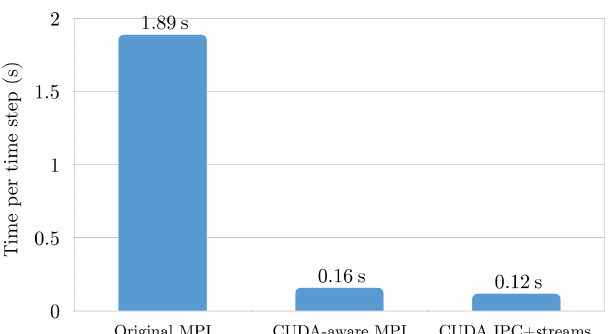
Figure 6. Computational performance of the spectral transform dwarf at 18km resolution ( N T = 639) on four NVIDIA V100 GPUs of the DGX1 with the original MPI implementation (left), CUDA- aware MPI communication (middle), and NVLink-optimised com- munication (right). This resolution is currently used operationally for the members of the ensemble forecast at ECMWF.